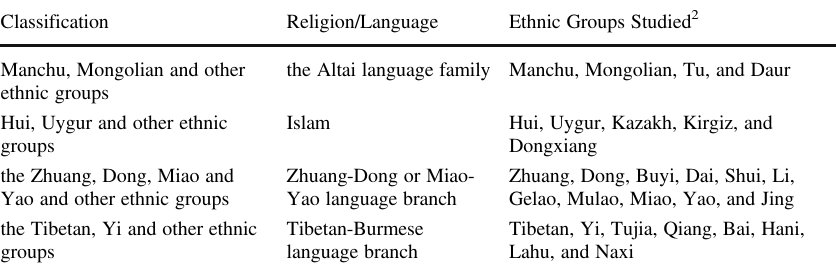
Table 1 The Classification of Ethnic Groups in Western China Classification